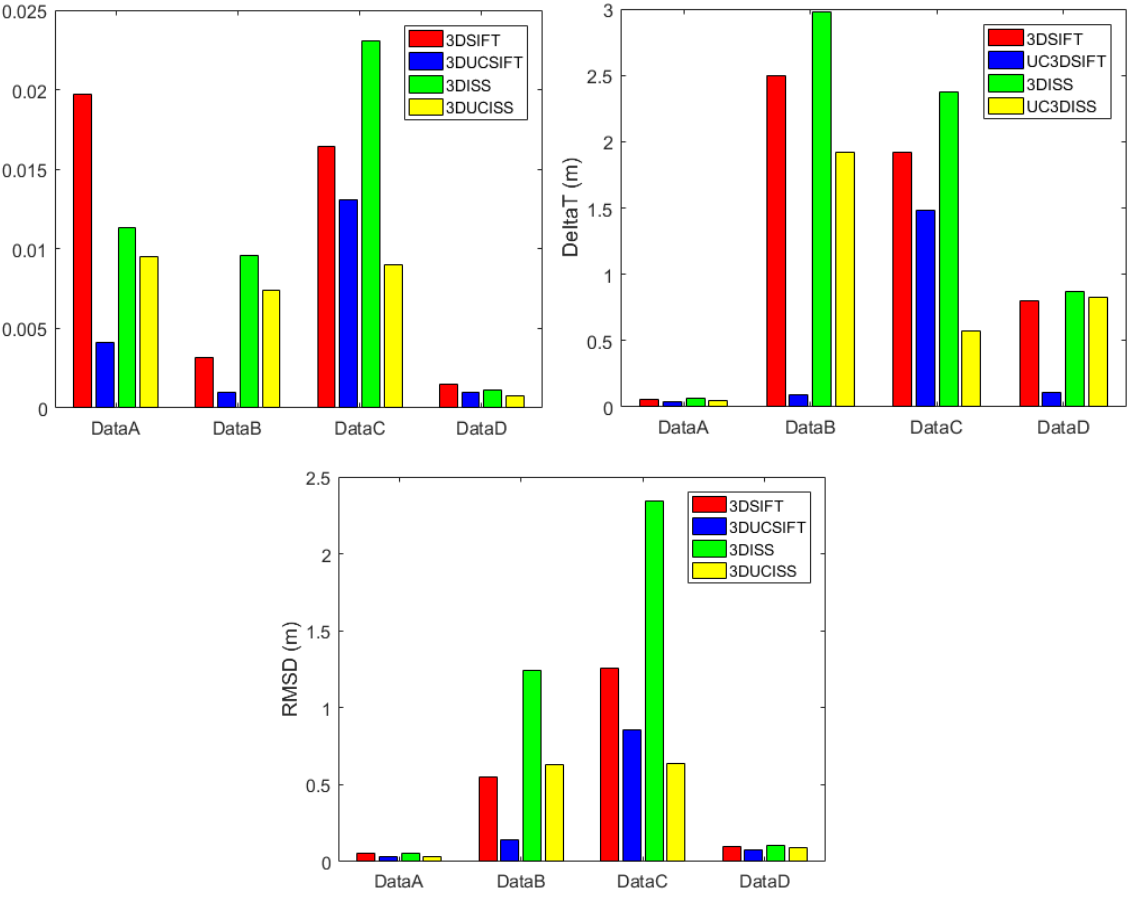
Figure 13. Results of positional accuracy